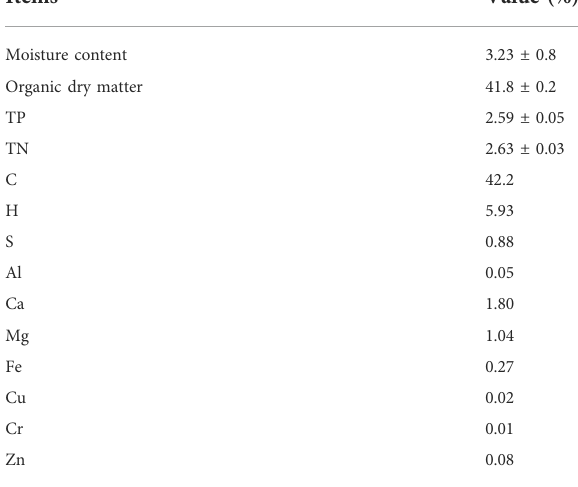
TABLE 1 Physical and chemical properties of swine manure.